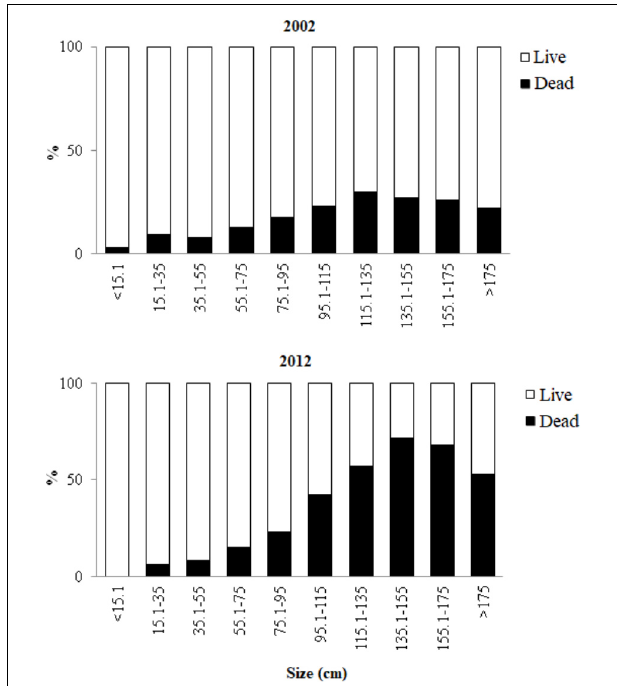
FIGURE 3 | Mean proportion of live and dead tissue among colonies within each size class in 2002 ( n = 213) and 2012 ( n = 261).